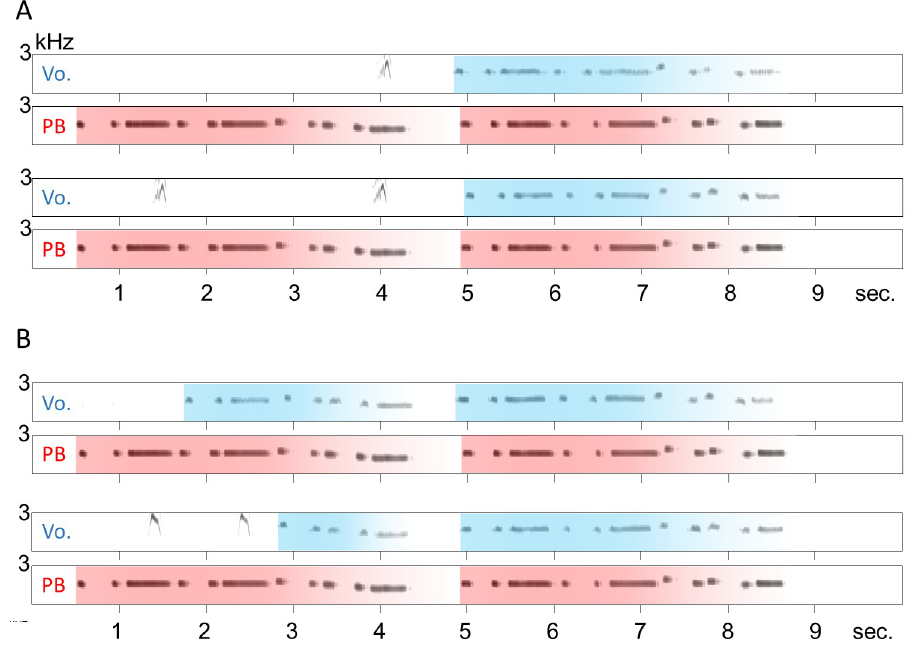
Fig 2. Examples of singing in response to playback sounds. These recordings were obtained from bird PY. Starting from the second half (A; the same recordings are shown as PY#6 and PY#10 in S1 File ). Starting from in the middle of the first half (B; the same recordings are shown as PY#12 and PY#13 in S1 File ).